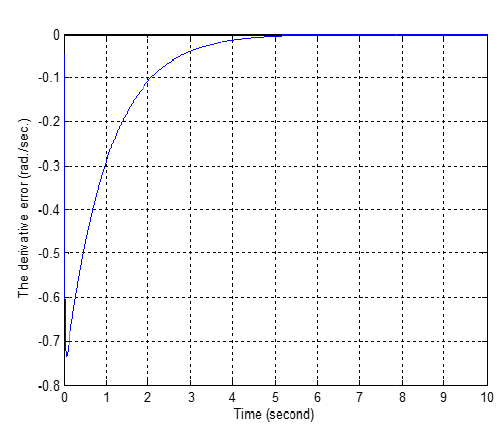
Fig. 16. The plot of phase plane between the error . The plot of phase plane between the error vs. time of the of the _ ‘ and the derivative error _ b of the CSMC. b